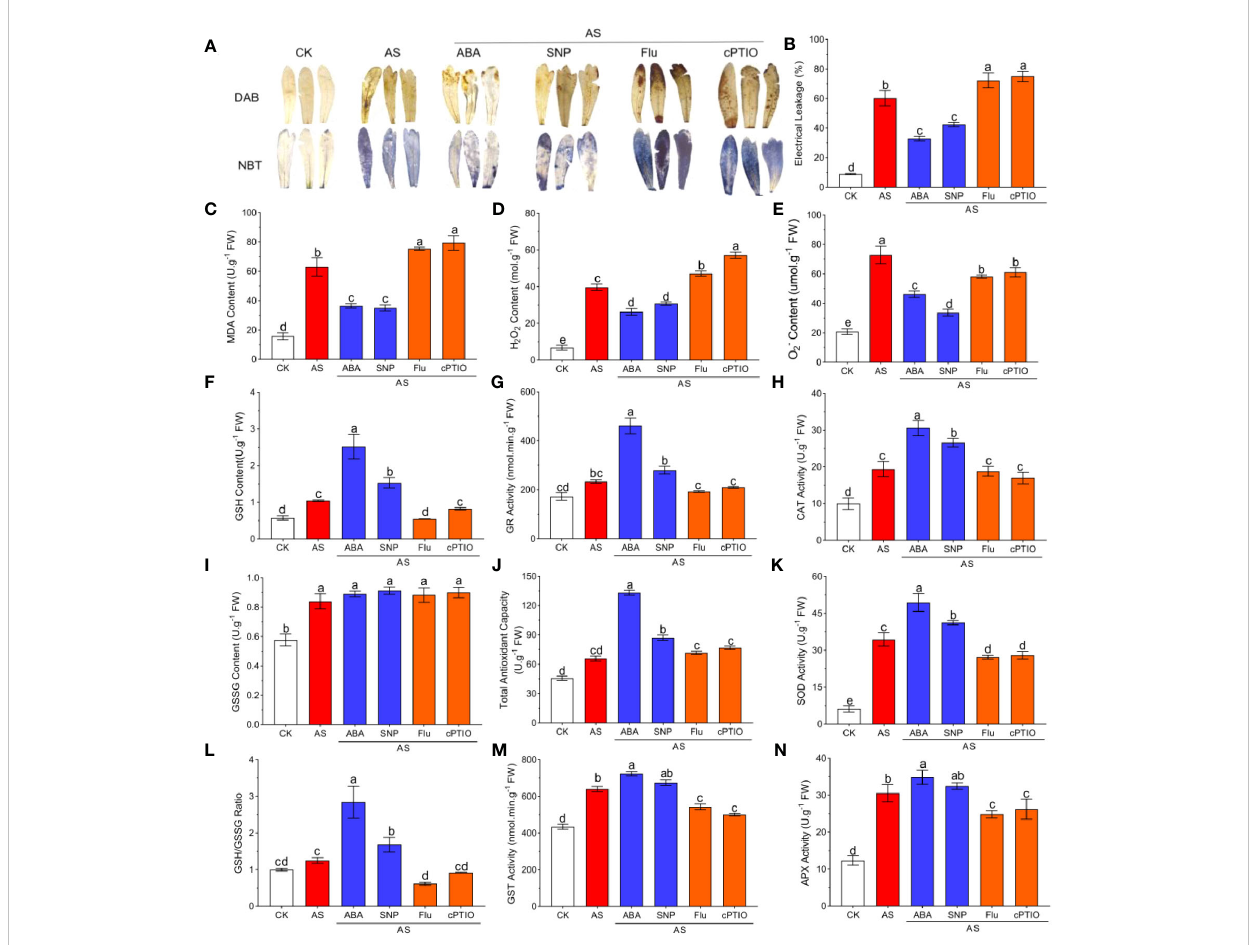
FIGURE 2 ABA and SNP alleviate ROS accumulation and accelerates antioxidant defenses under 100mM alkali stress in leaves (AS: NaHCO 3 : Na 2 CO 3 = 9:1, pH=9.5). Growth status of N. tangutorum 40-day-old seedlings treated with different treatments (100 mM alkali, 100 mM alkali +15 m m ABA/5 m m Flu, 100 mM alkali +50 m m SNP/70 m m cPTIO) for 12 days. (A) : DAB and NBT staining of the leaves; (B) : Electrical leakage (EL); (C) : MDA; (D) : Hydrogen peroxide content (H 2 O 2 ); (E) : Superoxide anion content (O 2- ); (F) : GSH content; (G) : GR activity; (H) :CAT activity; (I) : GSSG content; (J) : Total antioxidant capacity; (K) : SOD activity; (L) : GSH/GSSG ratio; (M) : GST activity; (N) : APX activity. Bars represent the means ± SDs of three replicates. Signi fi cant differences among treatments are indicated by different letters within a panel based on Duncan ’ s multiple range test ( P <